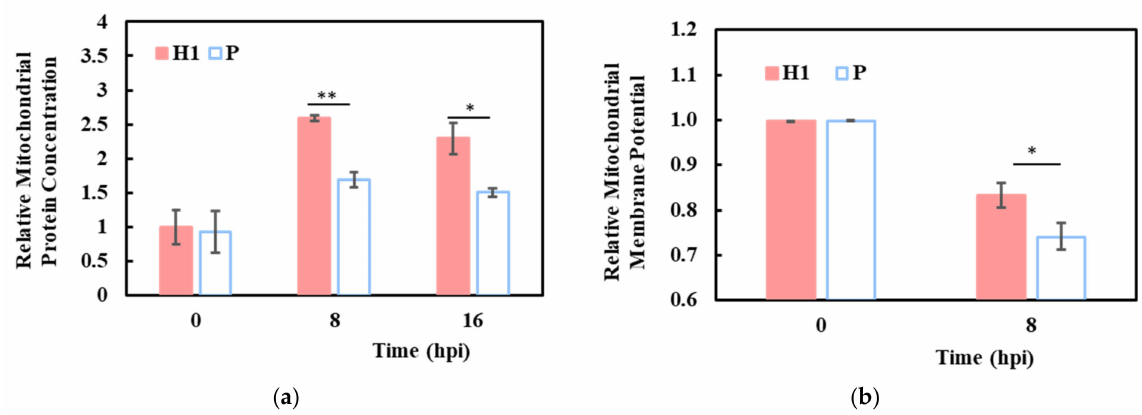
Figure 5. Elevated mitochondrial activities in H1 compared to P. ( a ) relative mitochondrial protein concentrations in H1 and P. ( b ) relative mitochondrial membrane potential in H1 and P. Experiments were done in triplicated infections. * p < 0.05, ** p < 0.01.